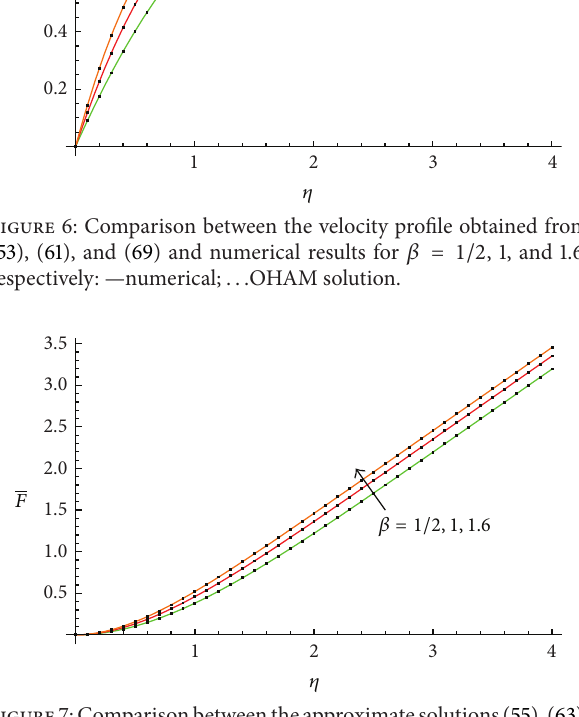
Figure 5: Comparison between the approximate solutions (53), (61), and (69) and numerical results with the auxiliary function equation (40) in the cases 𝛽 = 1/2 , 1, and 1.6, respectively: —numerical; ... OHAM solution.